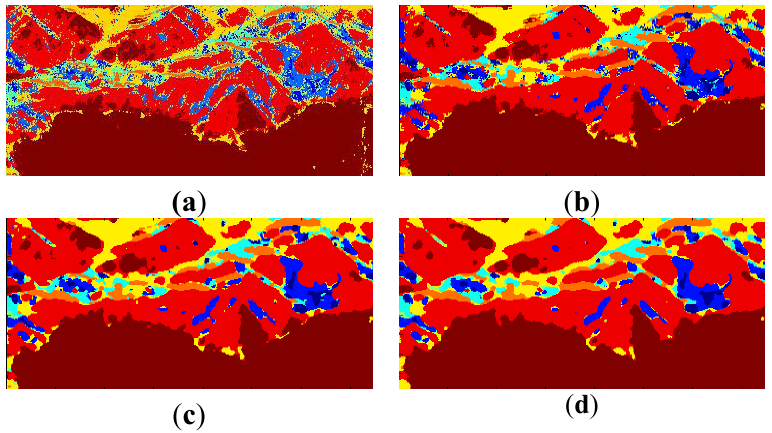
Figure 5. Expanded area corresponding to mountains extracted from Figure 4. ( a ) by the Wishart approach classification after two iterations, ( b ) by HNN optimization approach after the first iteration, ( c ) by ICM after the first iteration, ( d ) Majority.